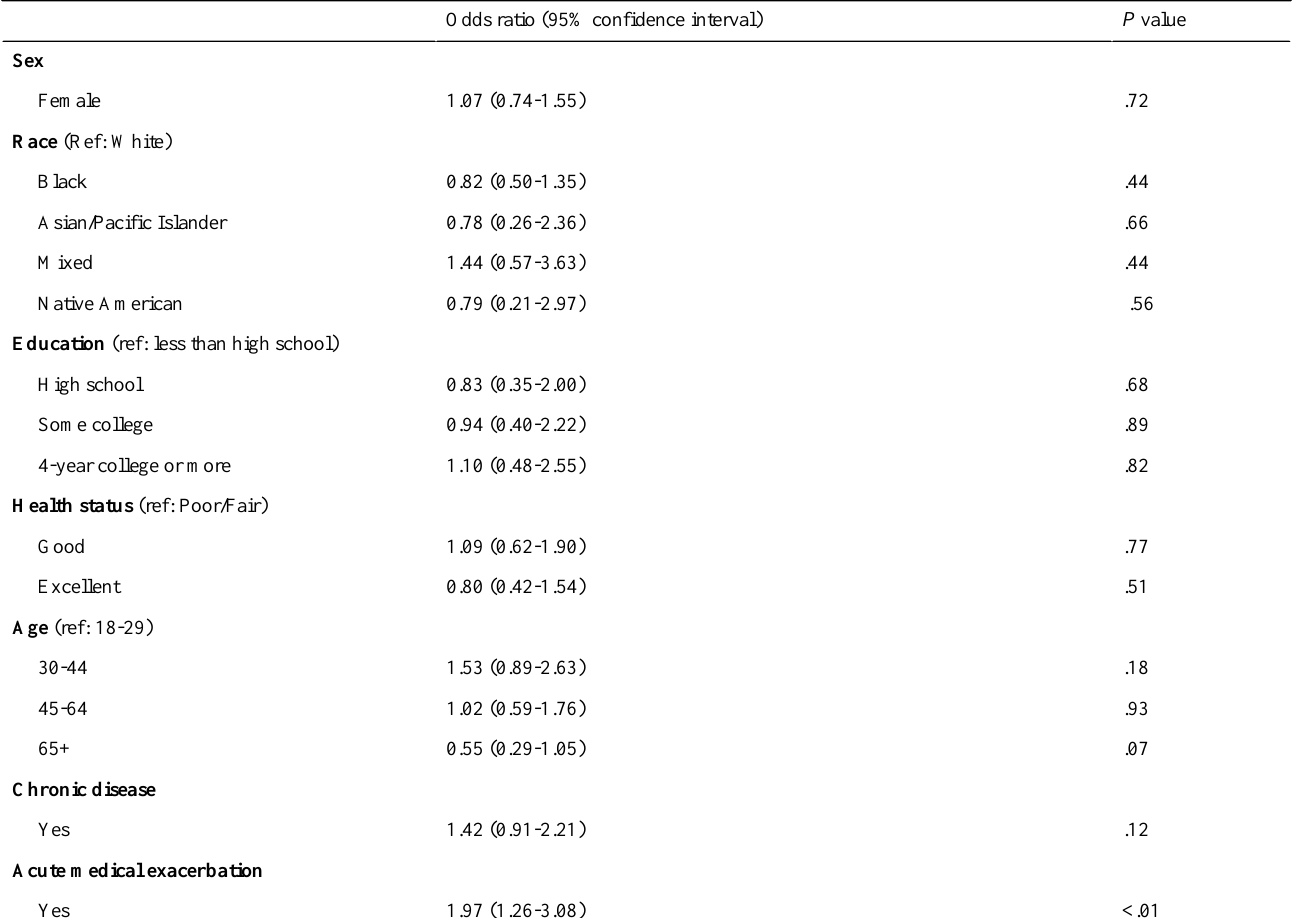
Table 3. Predictors of producing (versus consuming) Web-based health information.